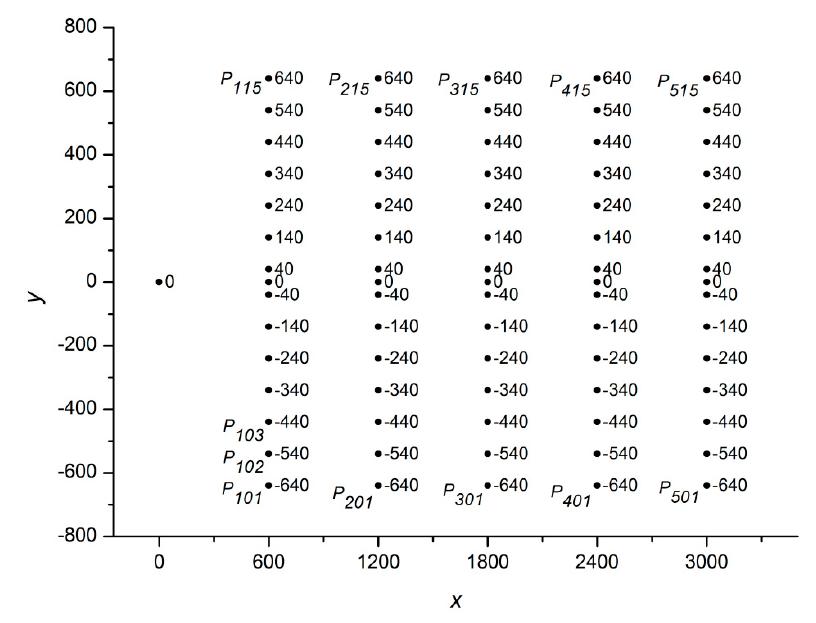
Figure 2. The schematic diagram of the measurement range.